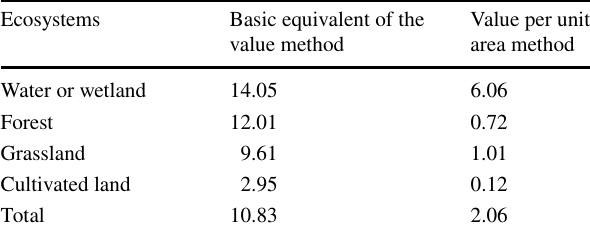
Table 4 The water productivities of ecosystems (¥/m 3 ) Ecosystems Basic equivalent of the value method